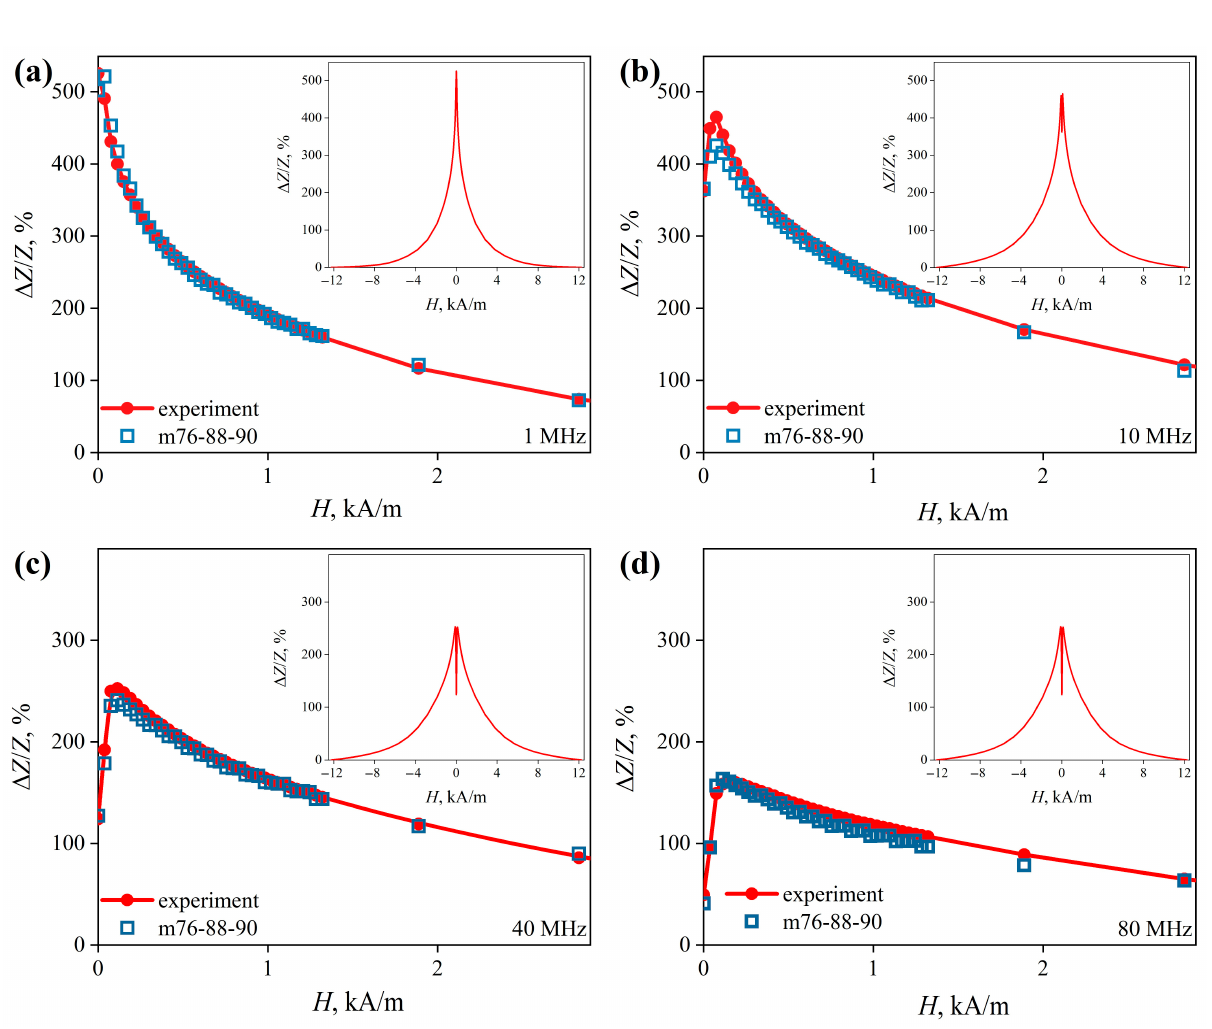
Figure 8. MI behavior for an amorphous Co 66 Fe 4 Nb 2.5 Si 12.5 B 15 wire. The line with round markers shows the dependences of the magnetoimpedance effect on the strength of the external magnetic field Δ Z/Z ( H ), obtained at AC frequencies: ( a ) 1 MHz, ( b ) 10 MHz, ( c ) 40 MHz, and ( d ) 80 MHz. The insets show the same dependences in the range of the magnetic fields from –12 to 12 kA/m. Square markers are data obtained using the m76-87-90 model.